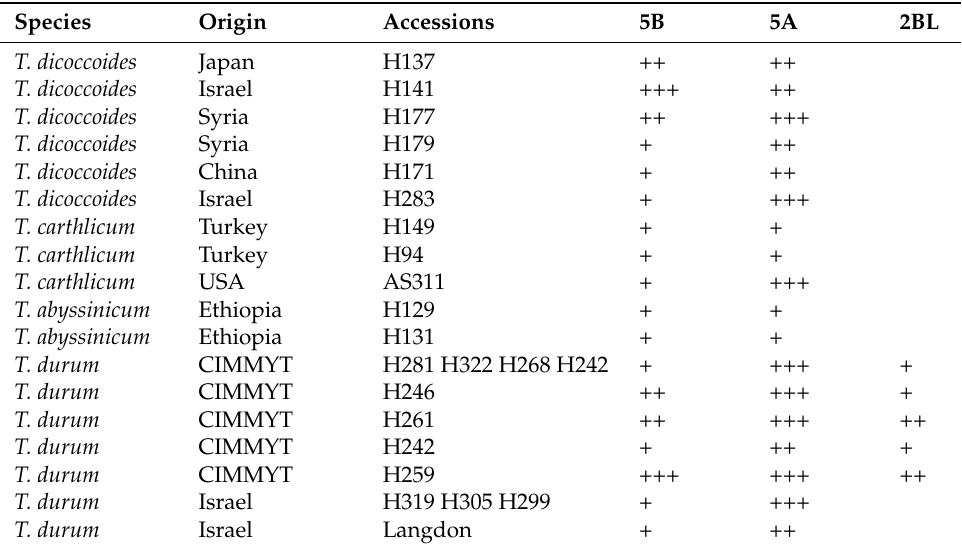
Table 3. The differential hybridization patterns of Ta-3A1 among tetraploid wheat.